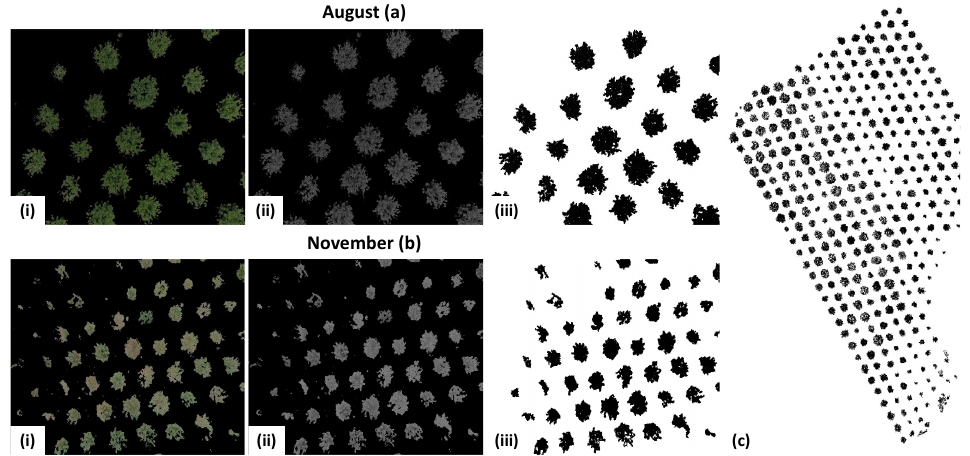
Figure 5. Image processing phases: isolated areas of interest [ a ( i ) and b ( i )]; noise removal [ a ( ii ) and b ( ii )]; grayscale transformation [ a ( iii ) and b ( iii )]; and agri-field mosaic following the image processing [( c )].